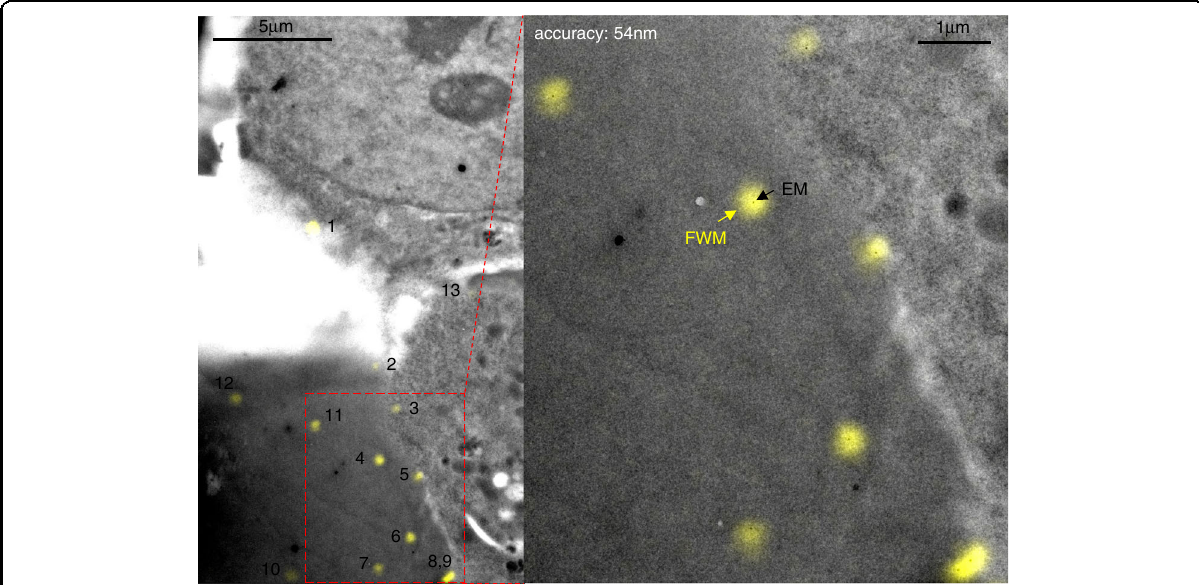
Fig. 3 CLEM correlation accuracy. Overlay of FWM fi eld amplitude (yellow) and TEM image (grey) from Fig. 1c (contrast adjusted for visibility). The FWM image is transformed into the EM reference system using a linear transformation matrix that accounts for translation, rotation, shear and scaling (see text). The correlation accuracy is indicated